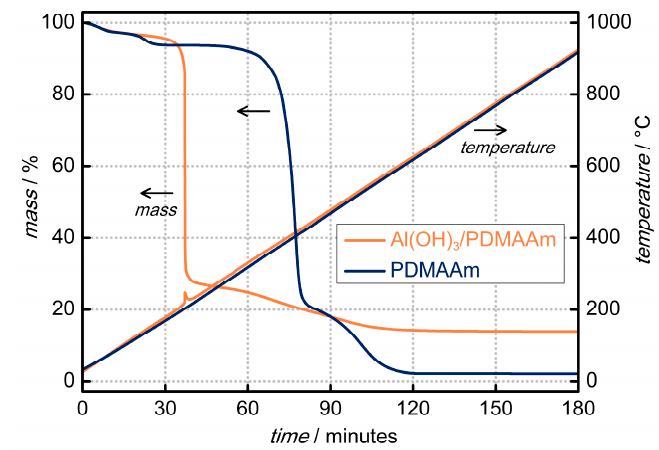
Figure 2. Thermo-gravimetric analysis (TGA) of the Al(OH) 3 -polymer composite and of the pure polymer PDMAAm.